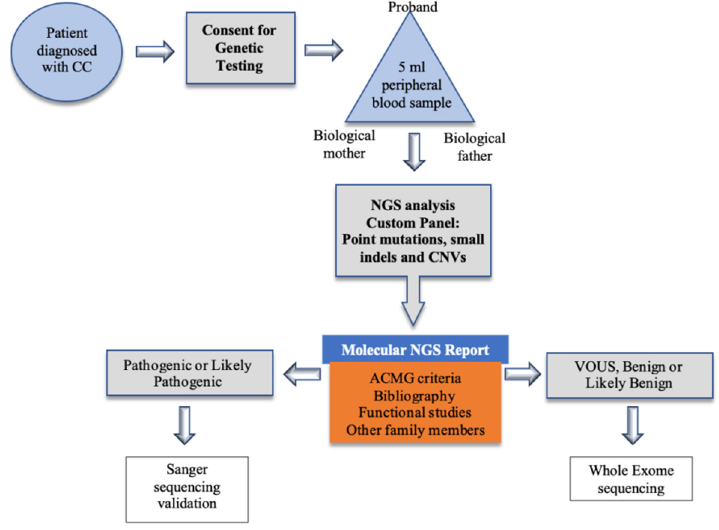
Figure 4. Congenital cataract diagnosis pathway. CC (congenital cataract). NGS (next-generation